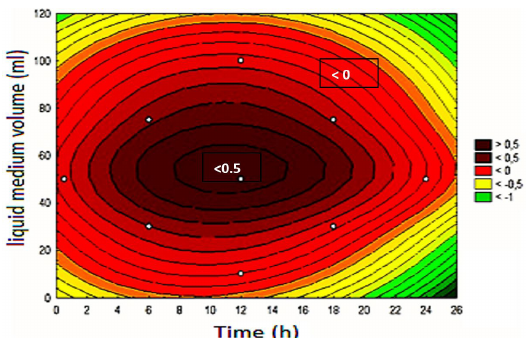
Figure 6. Contour plot of the response surface for phosphorus reduction of iron ore particles as a function of contact time and volume of the liquid medium of the bacterial